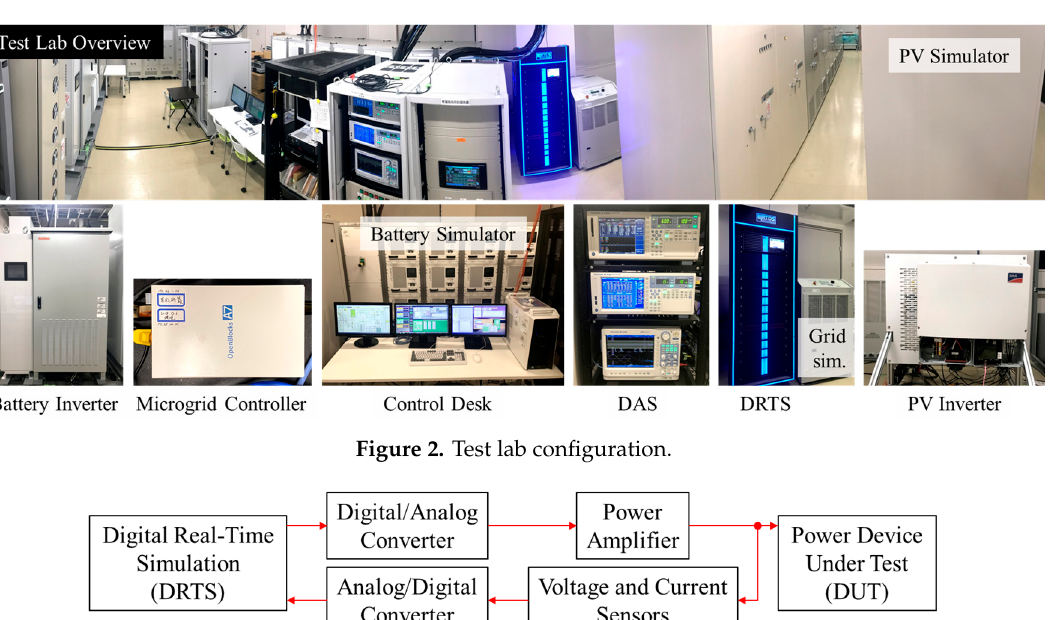
Figure 1. Aerial photo of power system related testing facilities in Fukushima Renewable Energy Institute, AIST (FREA) (source: Google Maps).